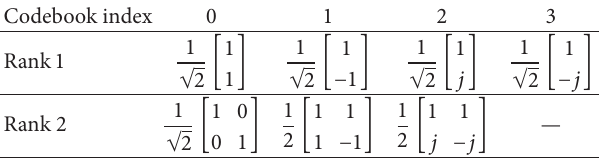
Table 1: Precoding matrices ( W ) for two antenna